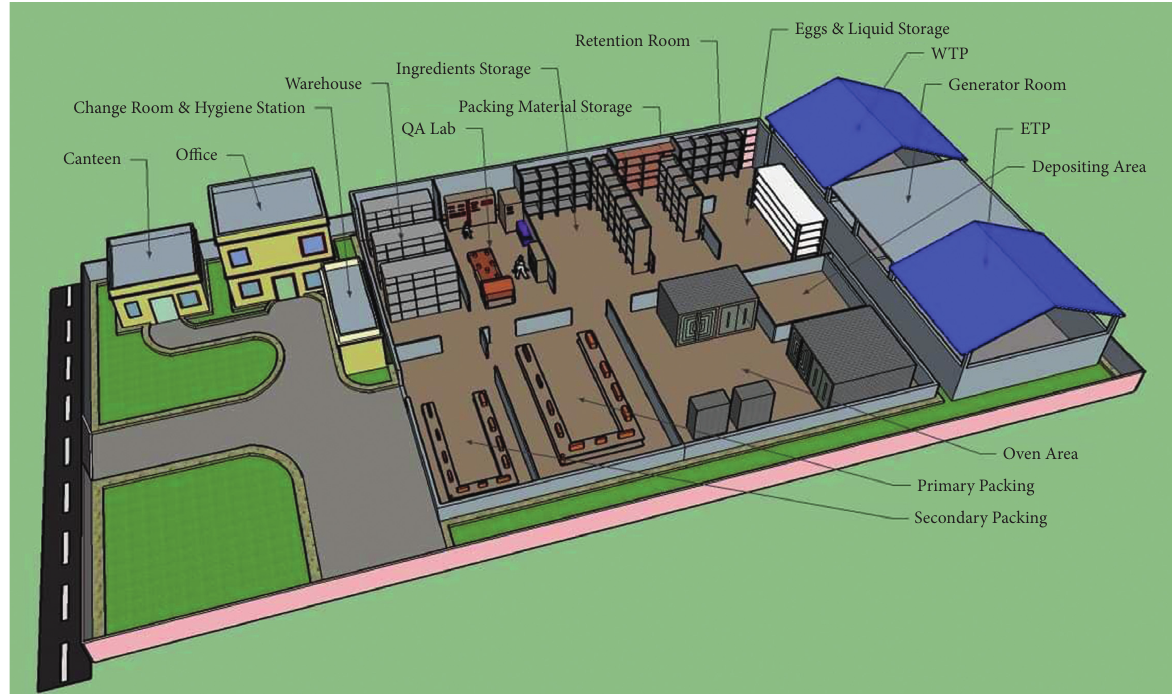
Figure 1: Layout of the plant